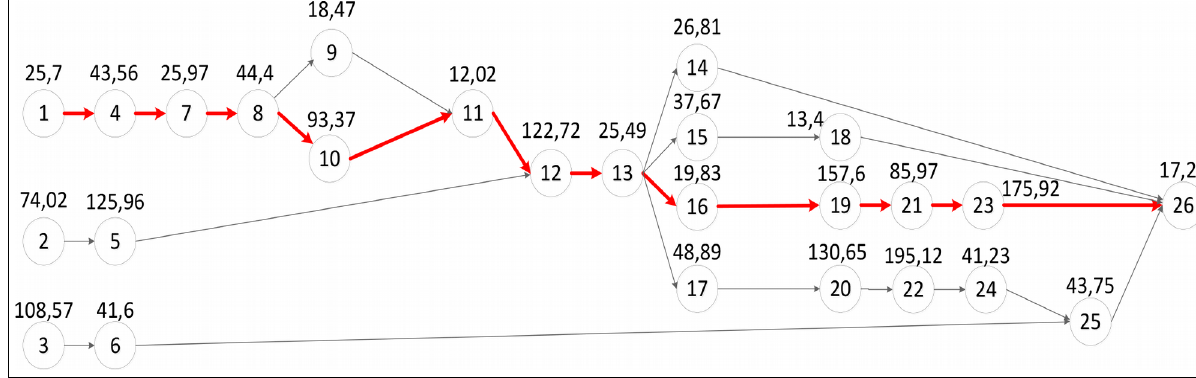
Figure 10. The AON for the PHB-TR 252 Assembly Process Using One Additional Worker for Particular Work Element (Rmax = 2)